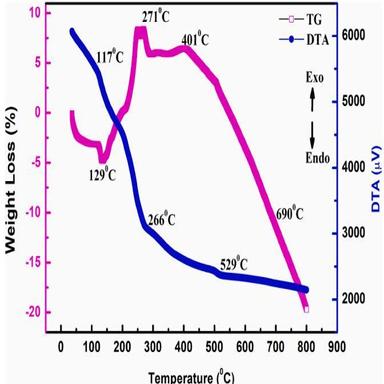
X-ray diffractograms of LSMN7382 powder: As-synthesized and calcined at 500 ◦C and 1200 ◦C for 2 h.